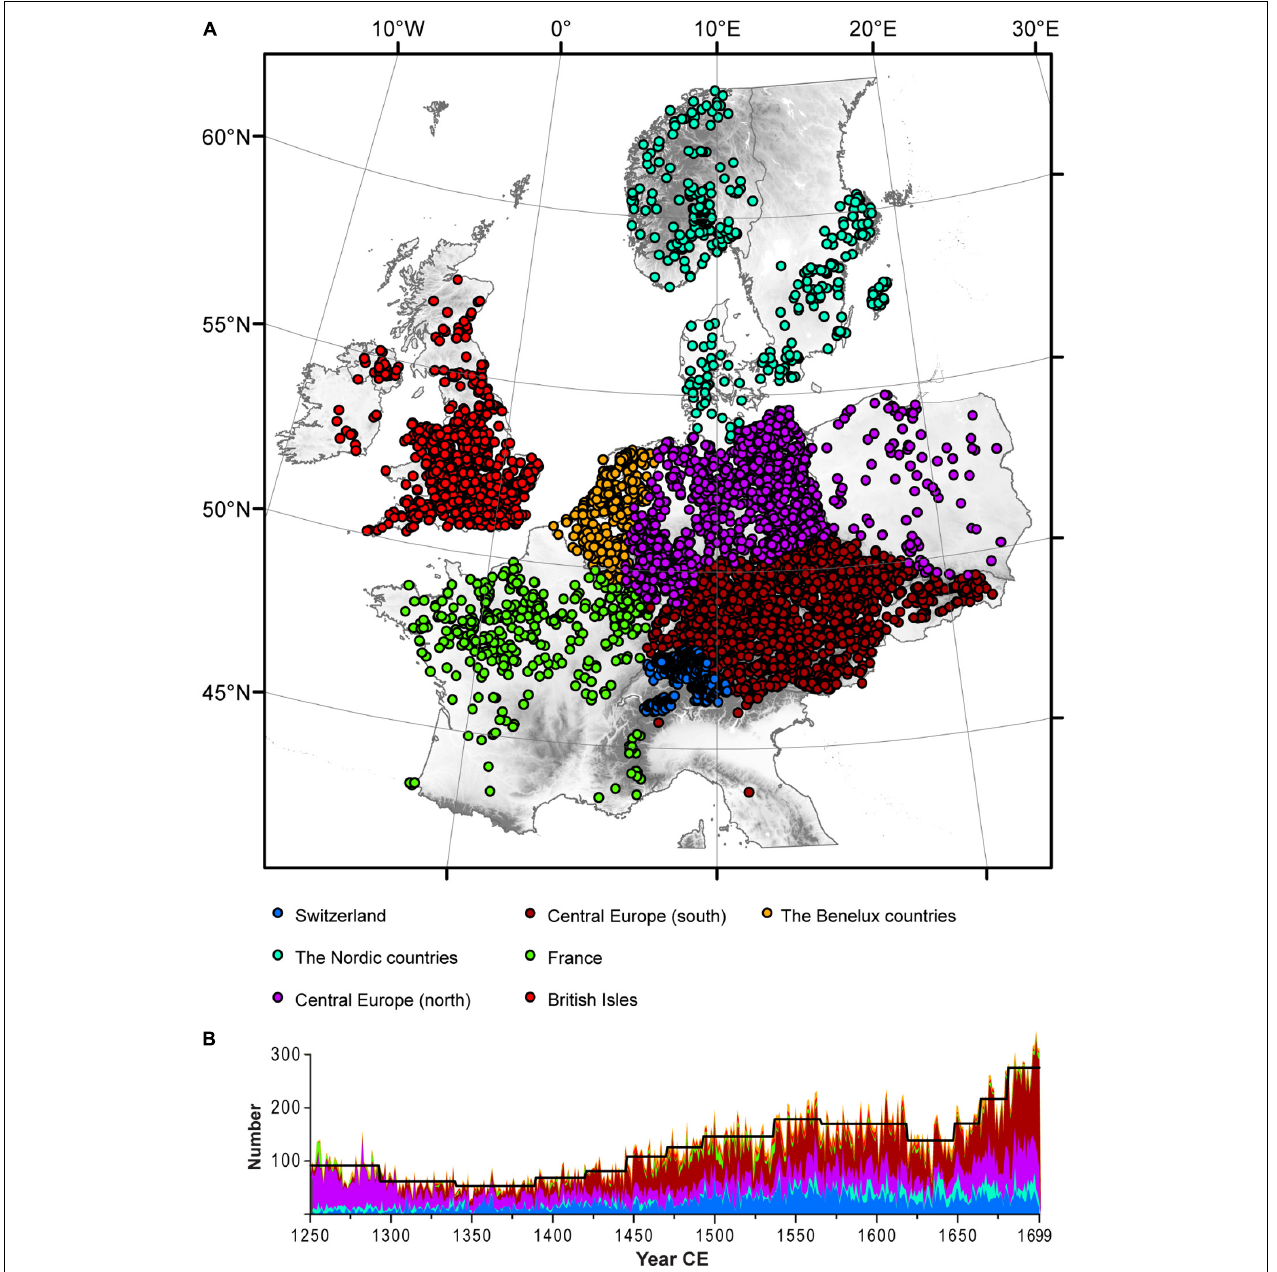
FIGURE 1 | (A) The geographical distribution of all 54,045 tree felling dates 1250–1699 CE from archeological and historical construction timber displayed using the Lambert conformal conic projection in ArcGIS and displayed with contemporary political boundaries. (B) Number of felling dates per year for each regional dataset [color-coded as in (A) ] over the period 1250–1699 CE. The black line shows the significant regime shifts in the number of felling dates using the full